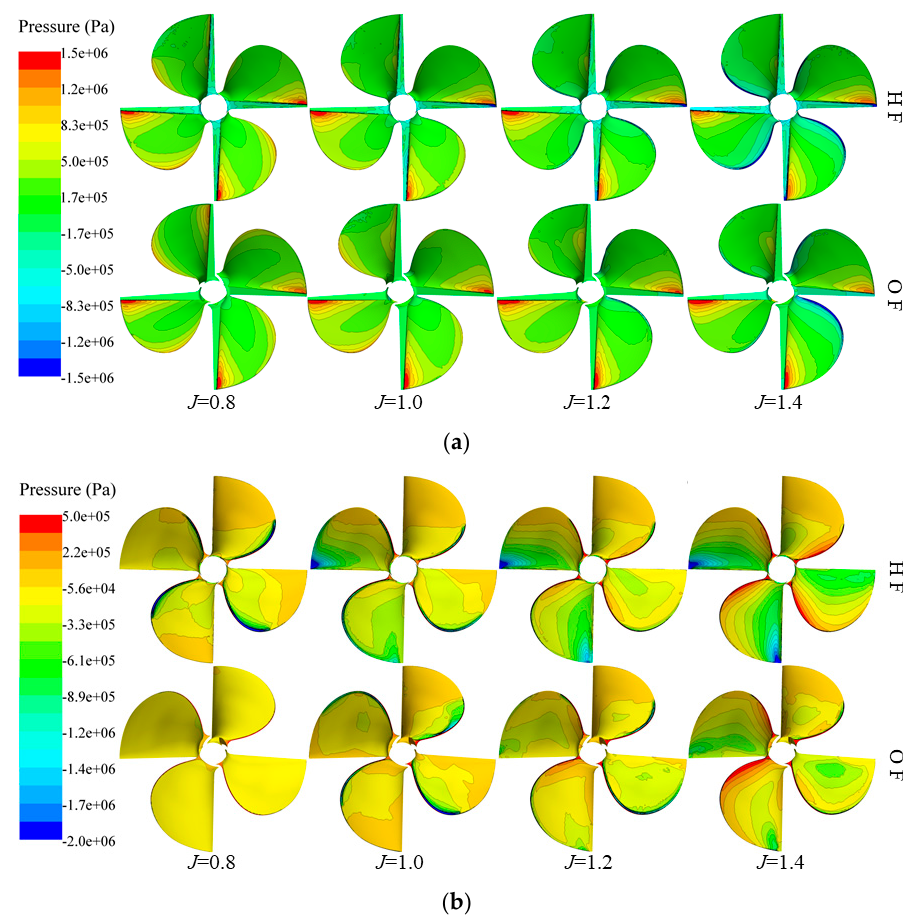
Figure 15. Pressure distribution on blade surfaces. ( a ) The pressure distribution on pressure side; ( b ) the pressure distribution on suction side.